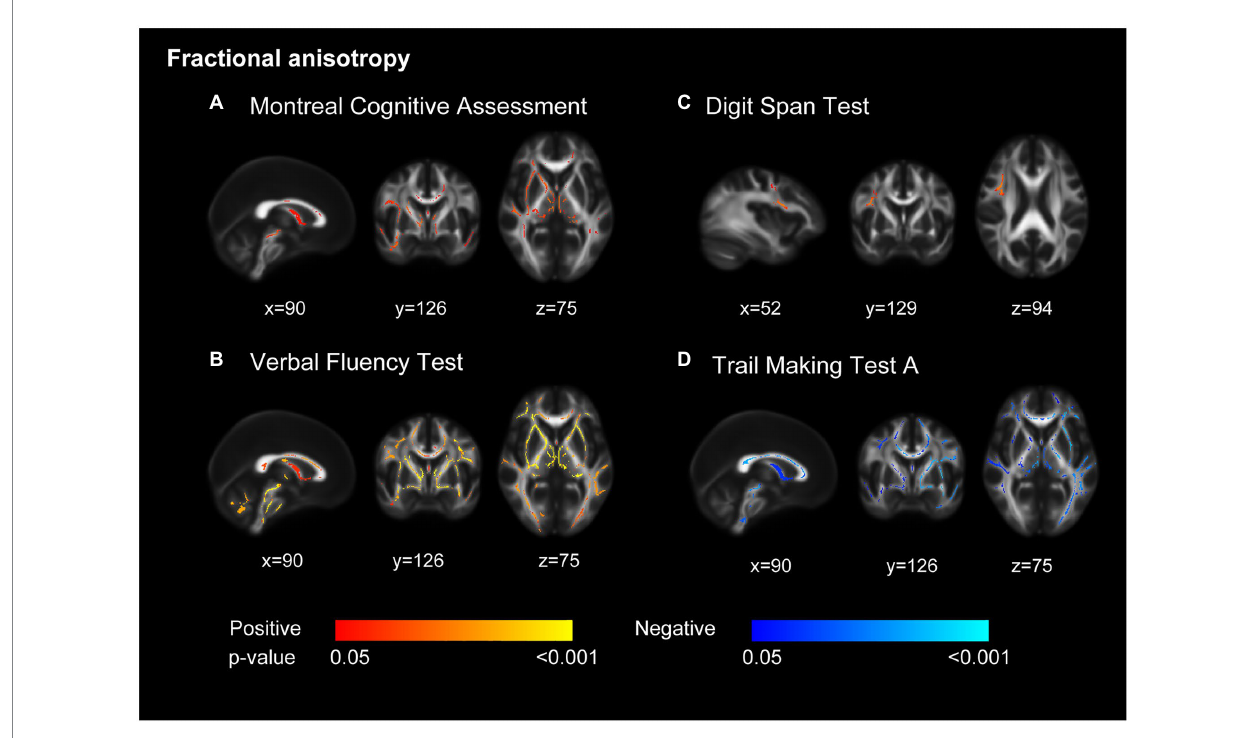
FIGURE 1 Decreased white matter integrity related to cognition. Decreased fractional anisotropy was associated with lower scores in Montreal Cognitive Assessment (MoCA) (A) , Verbal Fluency Test (B) , Digit Span Test (C) , and longer completion time in Trail Making Test part A (D) . Models adjusted for age, sex, education, and ApoE ε 4 carrier. All results were significant at p < 0.05 (threshold-free cluster enhancement corrected) and overlaid on mean fractional anisotropy map in Montreal Neurological Institute normalized space. The orange and blue lines indicate positive and negative associations between fractional anisotropy and cognition